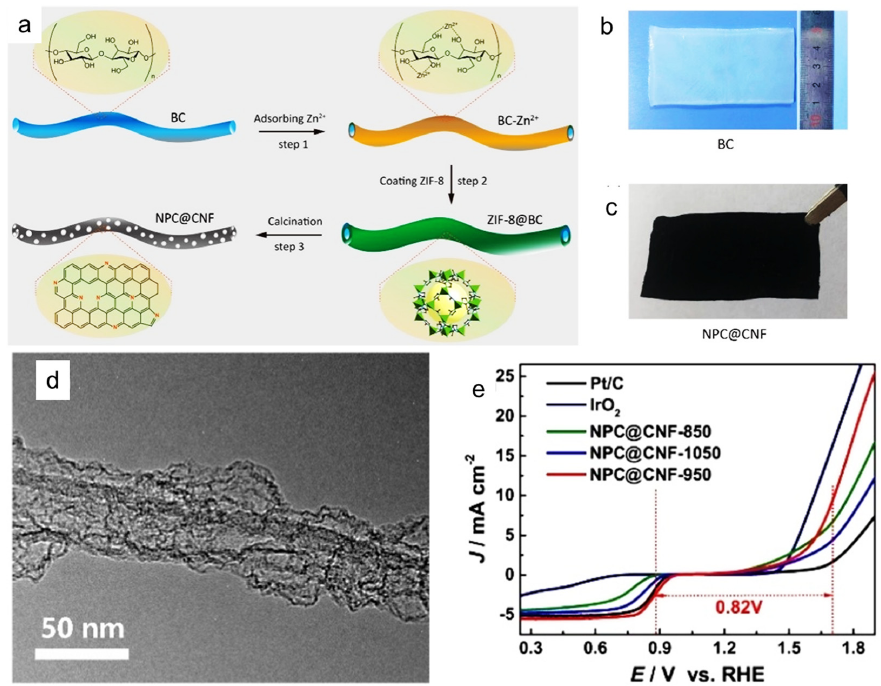
Figure 2. Typical preparation procedure and oxygen ‐ related reaction performance of NPC@CNF.